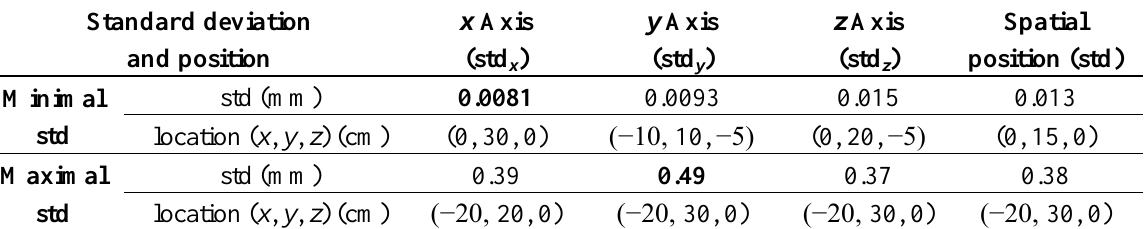
Table 1. Standard deviations of static